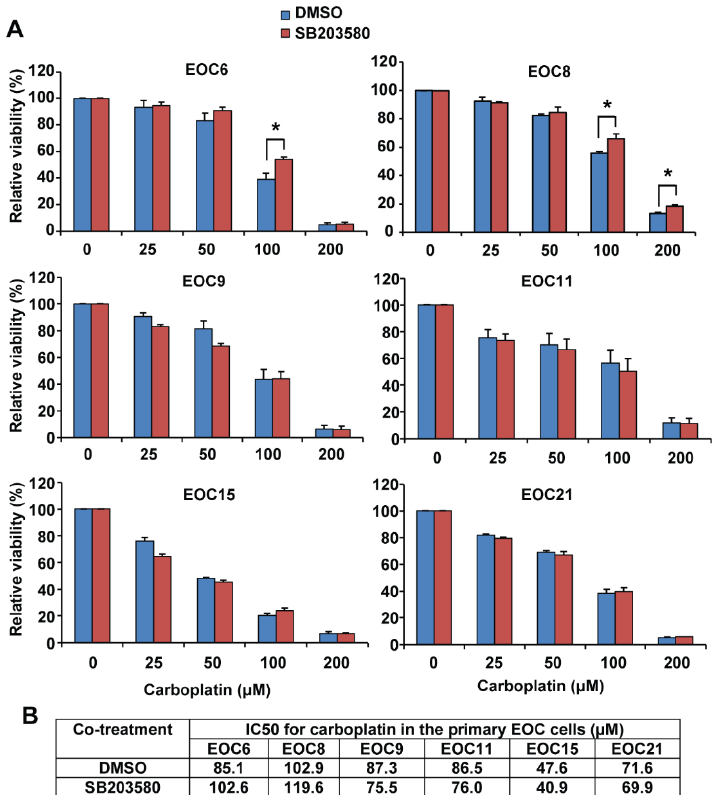
Figure 3. Inhibition of p38 MAPK by SB203580 has minimal or no effect on carboplatin sensitivity in primary epithelial ovarian cancer (EOC) cells. Primary EOC cells isolated from ascites of six patients with high ‐ grade serous EOC were cultured in adherent condition for one day and then treated with increasing concentrations of carboplatin in the presence of SB203580 (10 μ M) or an equal volume of DMSO (the vehicle control) for 72 h. Cell viability was determined by the neutral red uptake assay. ( A ) Data are shown as mean ± SE of three to five independent experiments. * Significantly different ( p < 0.05). ( B ) The IC 50 for carboplatin in these primary EOC cells in the presence of SB203580 or DMSO is shown. Int. J. Mol. Sci. 2018 , 19 , x FOR PEER REVIEW